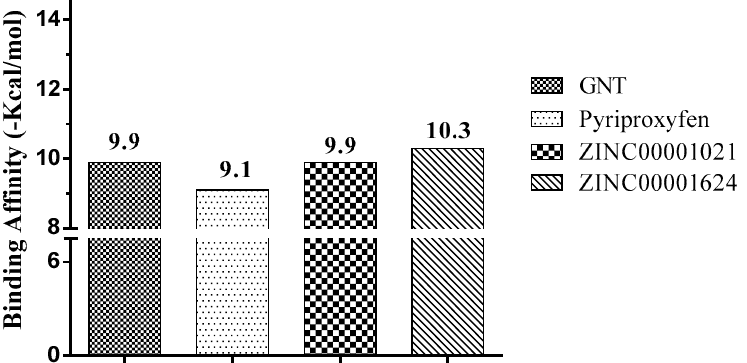
Figure 5. Results of binding affinity of the compounds with human acetylcholinesterase ( h AChE), PDB ID 4EY6.